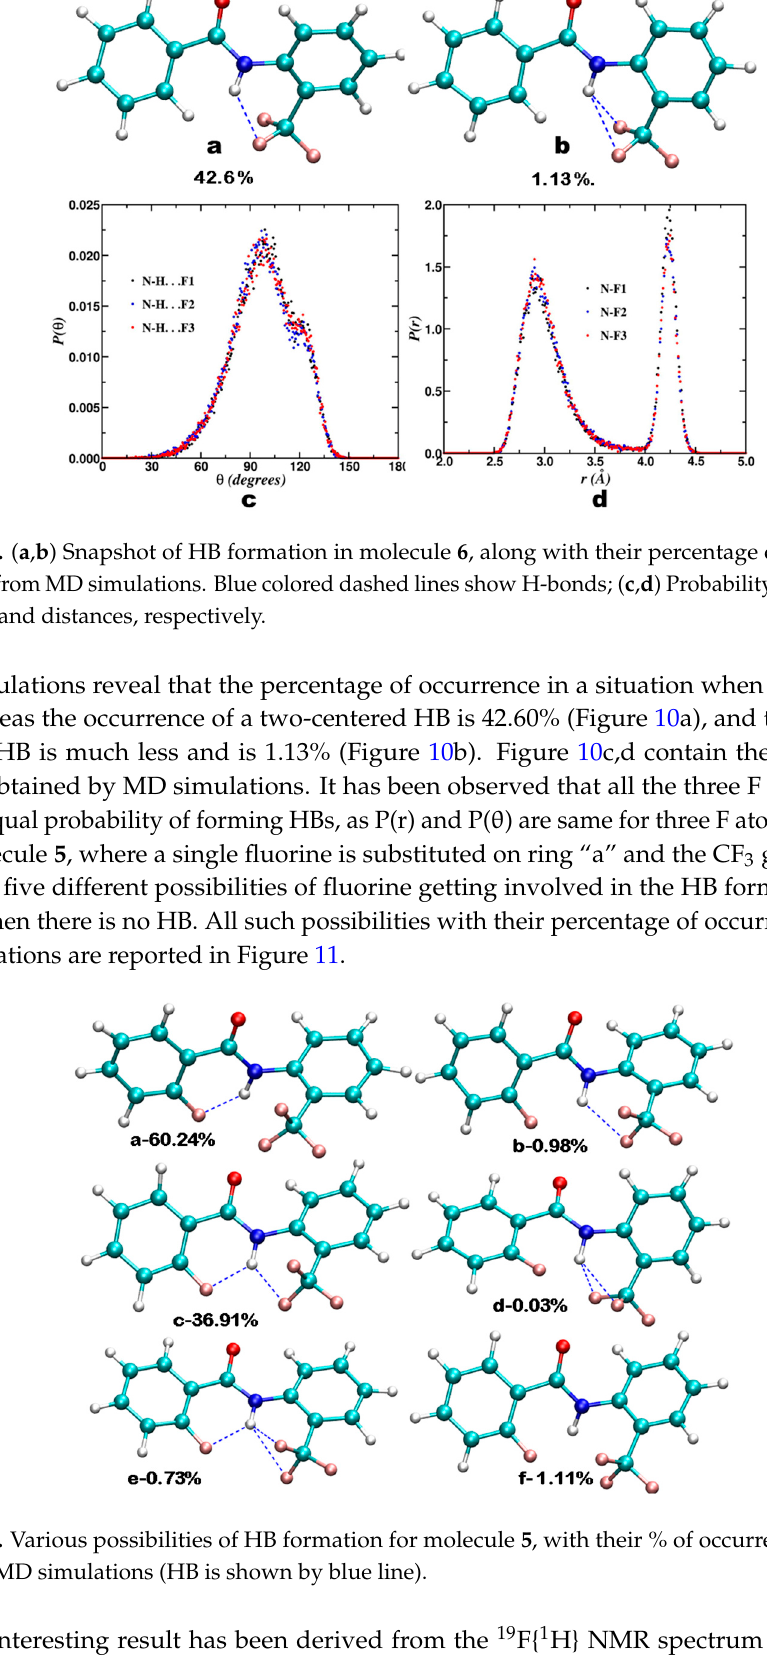
Molecules 2017 , 22 , 423 10 of 41 Figure 9. 400 MHz two-dimensional 15 N- 1 H-HSQC spectrum of molecule 5 in the CDCl 3 , depicting the through-space couplings. The measured coupling strengths are identified by a − d and their values have also been reported. 3.2. Theoretical Calculations To ascertain the presence of weak molecular interactions established by NMR experiments in these molecules, the DFT based theoretical calculations have been carried out. Gaussian09 has been used at B3LYP/6-311+g (d,p) level of theory [118] for full-geometry optimizations of the molecules 5 – 8 . With the presence of three fluorine atoms in the CF 3 group there are various possible ways of interactions, such as, two centered, three-centered, or four-centered HBs. To derive the quantitative information about HBs, quantum chemical calculations and MD simulations have been carried out. For calculation, the geometry measurement criteria have been used in which HB is represented as N-H···F, where N is the donor atom and F is the acceptor atom. If the distance, r between N and F